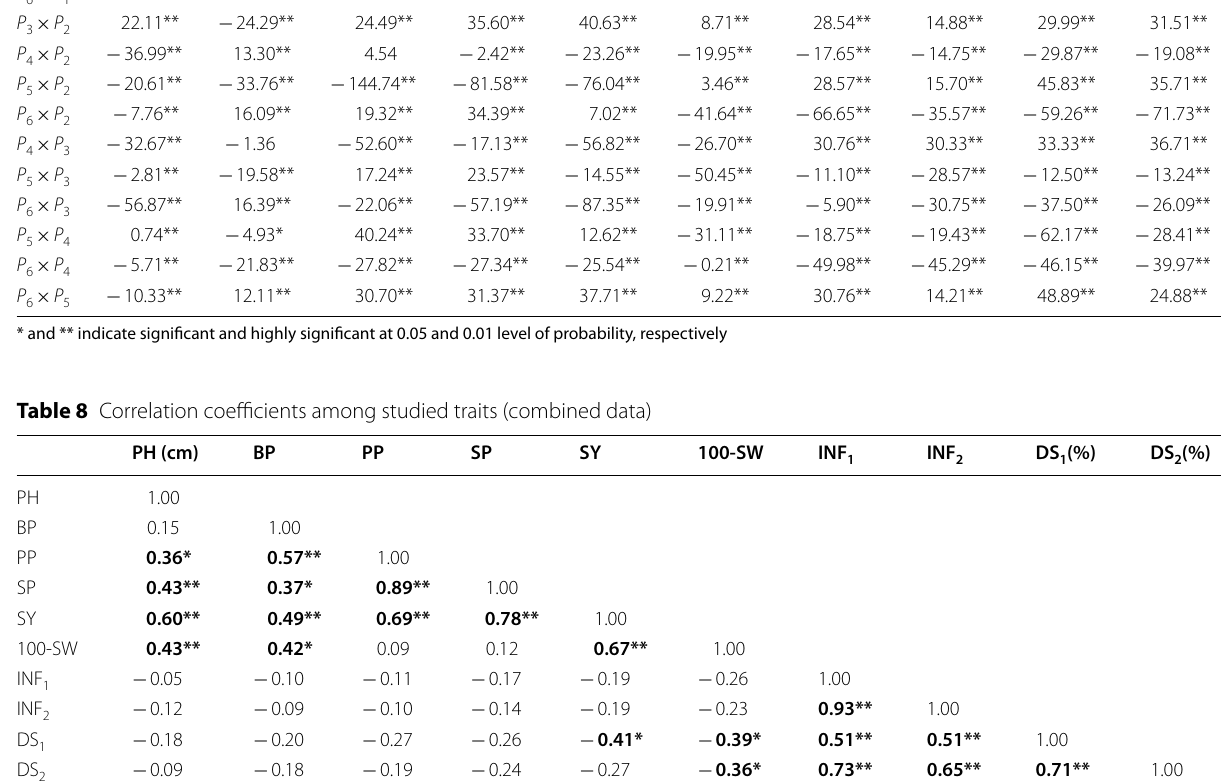
* and ** indicate significant and highly significant at 0.05 and 0.01 level of probability,